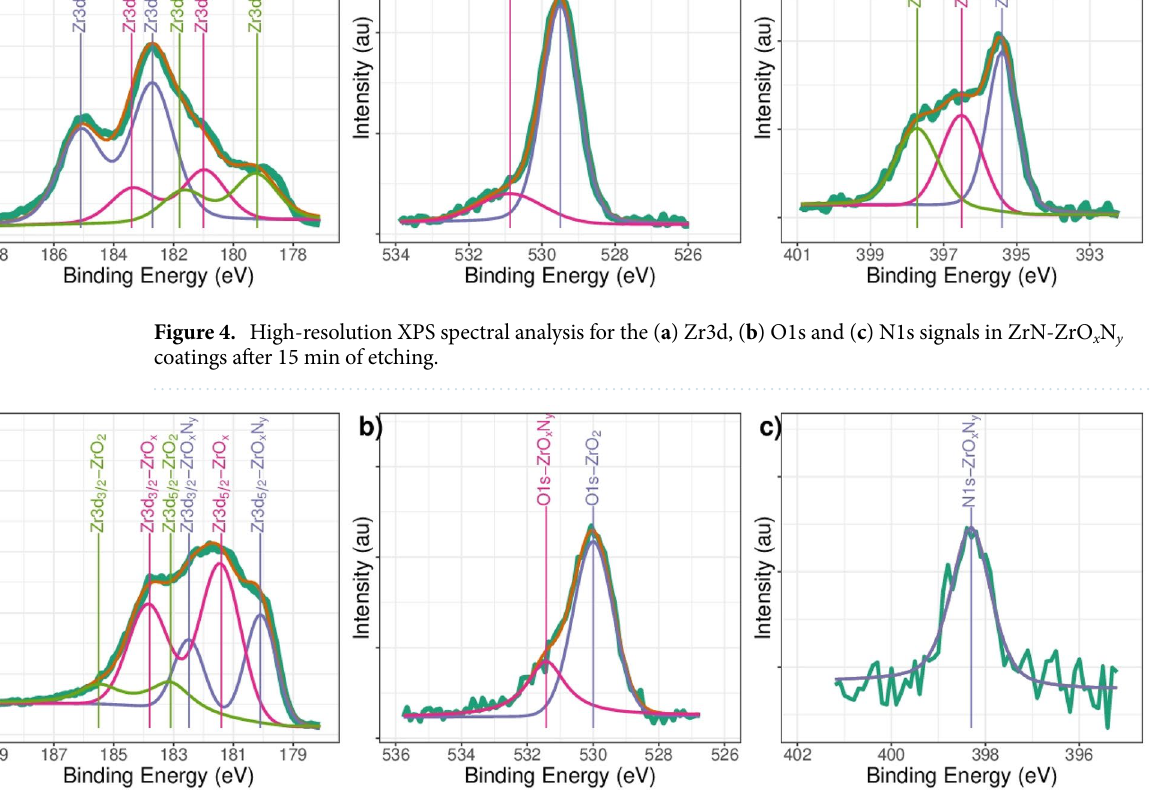
Figure 5. High-resolution XPS spectral analysis for the ( a ) Zr3d, ( b ) O1s and ( c ) N1s signals in ZrO 2 -ZrO x N y coatings after 15 min of sputter